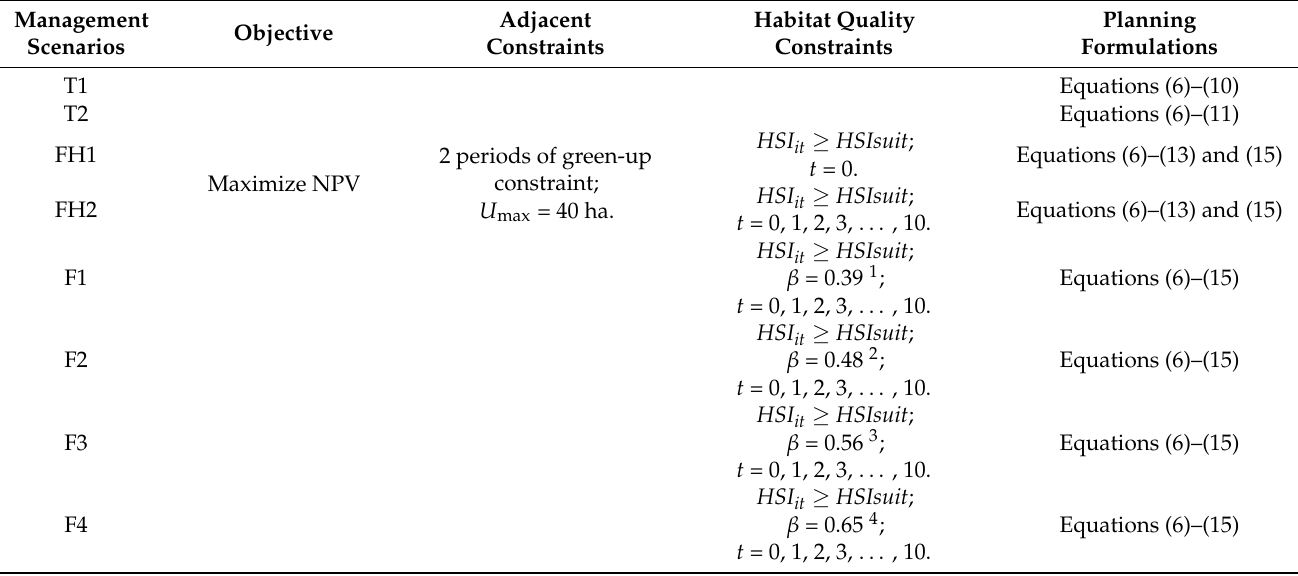
Table 2. Overview of the various management scenarios for the planning